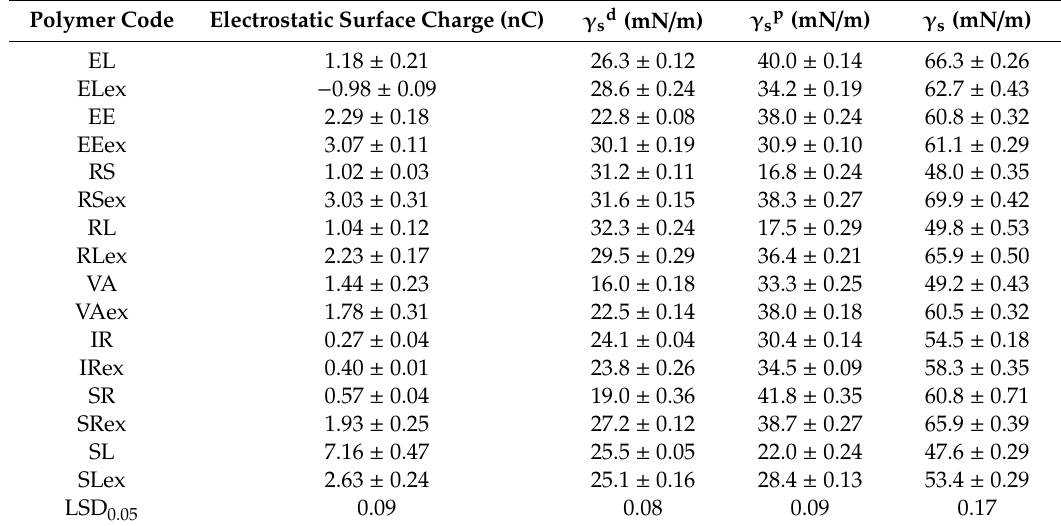
Table 4. Results of electrostatic surface charge and surface free energy components (mean values ± SD, n = 3, Least Significant Di ff erence LSD 0.025